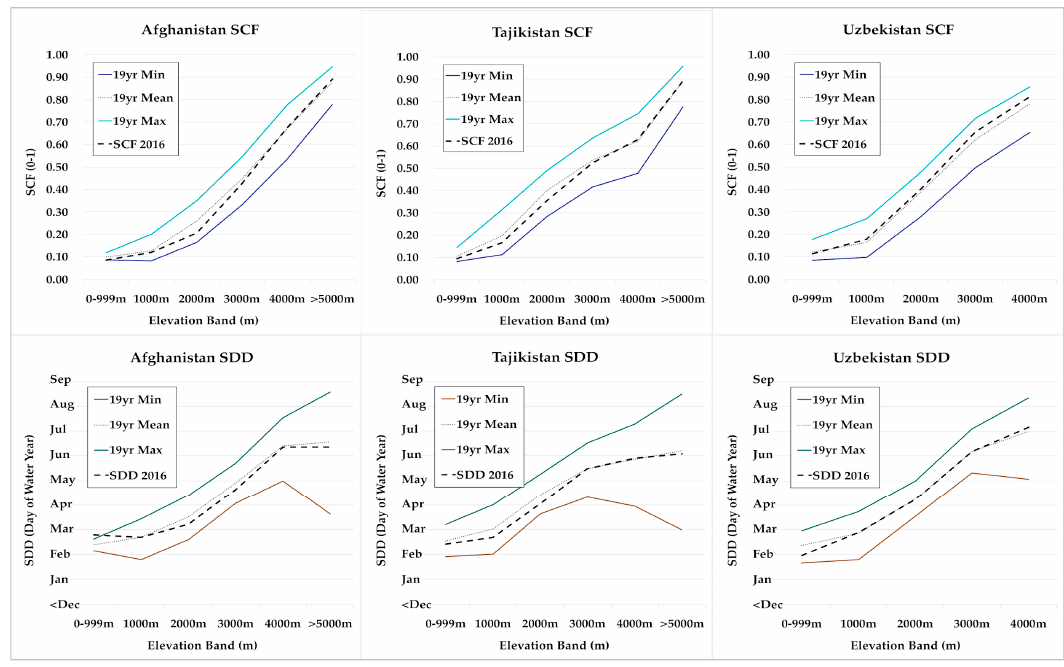
Figure 8. The snow cover frequency (SCF) values and snow disappearance date (SDD) values for the Amu Darya Basin (ADB) binned by elevation and spatially subset by country. The WY2016 data is plotted against the average, maximum, and minimum of 19 years of SCF and SDD data.